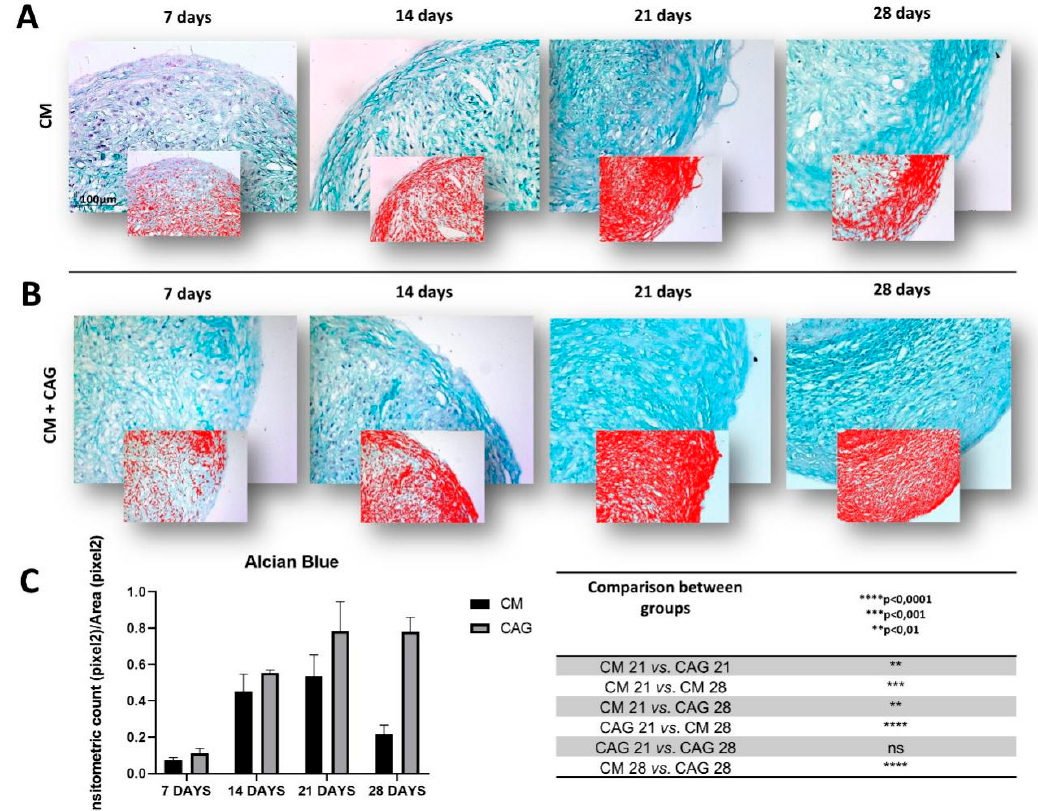
Figure 3. Histochemical evaluation of the mucosubstance content glycosaminoglycan (GAGs) in 3D AMSC-derived chondropellets at 7, 14, 21, and 28 days of culture by Alcian Blue staining through computerized densitometric measurements and image analysis. ( A ) control group (chondrogenic medium: CM); ( B ) CAG-supplemented group (CM + CAG). The smaller attached images represent the image analyses by the software: red color corresponds to high-intensity Alcian Blue staining confirming the sGAG synthesis. ( C ) Graph representing the level of staining expressed as densitometric count (pixel 2 ) normalized to the area of each section expressed in pixel 2 . Results were presented as the mean ± SD. ANOVA was used to evaluate the significance of the results. ** p < 0.01; *** p < 0.001; **** p < 0.0001; ns, not significant. See the Materials and Methods section for details. ( A , B ) Objective lens, 10×; scale bar: 100 μ m.